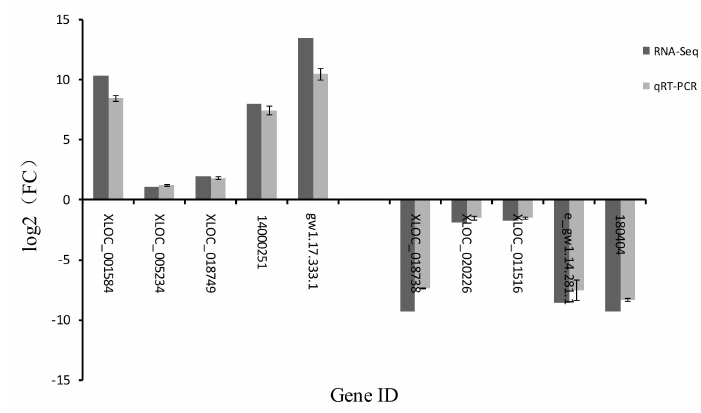
Figure 8. Comparison of gene expression patterns obtained using RNA-Seq and qRT-PCR. The X -axis shows genes validated in this study; the Y -axis shows the log2 ratio of expression in SD1-9 versus SD1.